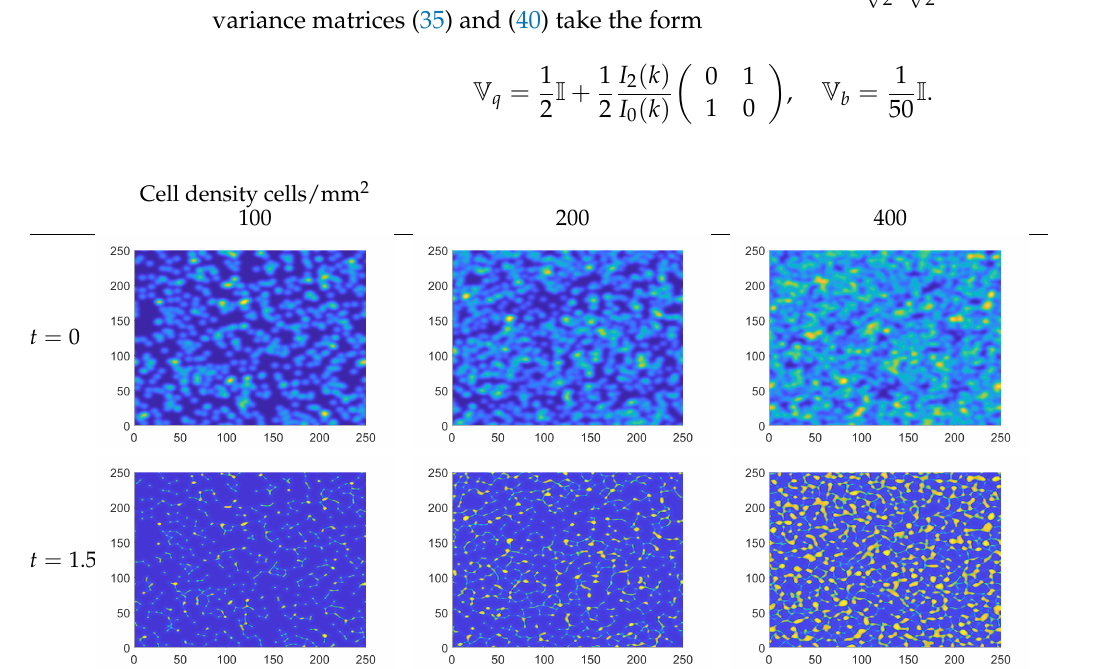
Figure 3. Formation of networks: The first row shows random initial conditions with cell densities of 100, 200, 400 cells/mm 2 . The second row shows the solution at time t = 1.5 s for cell density of 100, 200, 400 cells/mm 2 ,